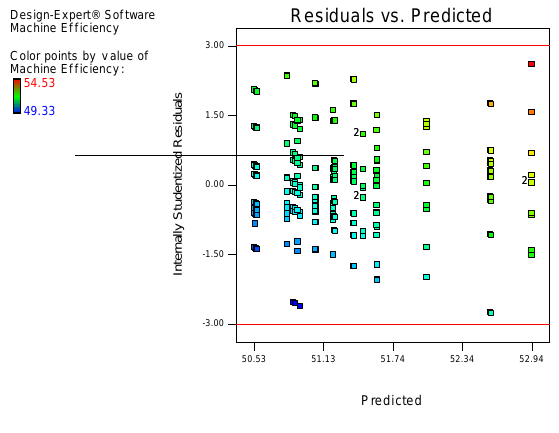
Figure 17. Residuals versus predicted values for machine